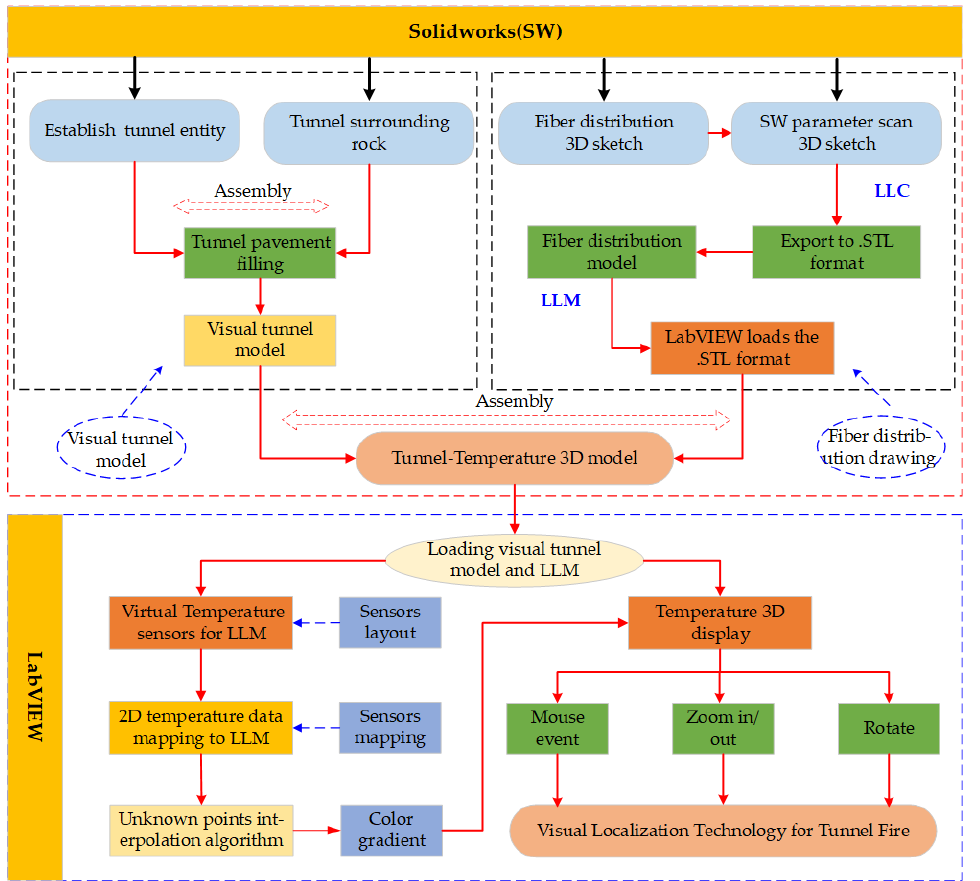
Figure 3. The flow chart of visual localization technology for tunnel fire.